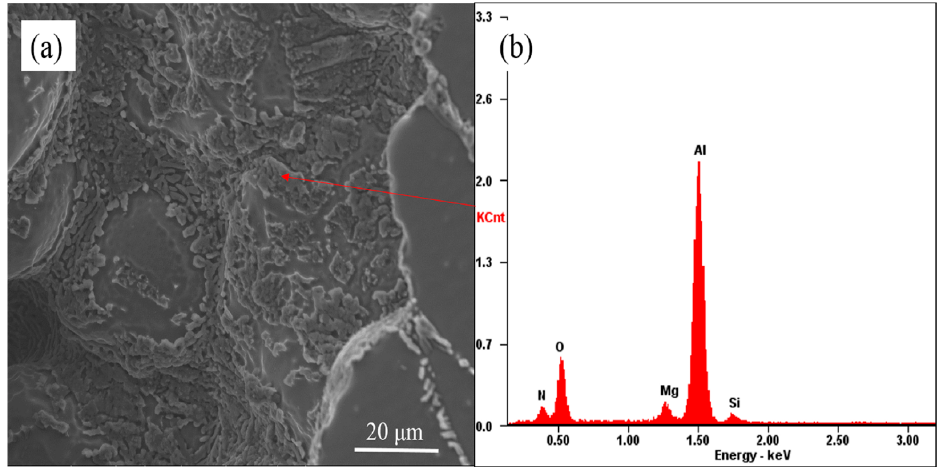
Figure 8. ( a ) The micro-morphology of A356 alloy scraps after being held in A356 alloy melt for 30 min; ( b ) Corresponding EDS results.